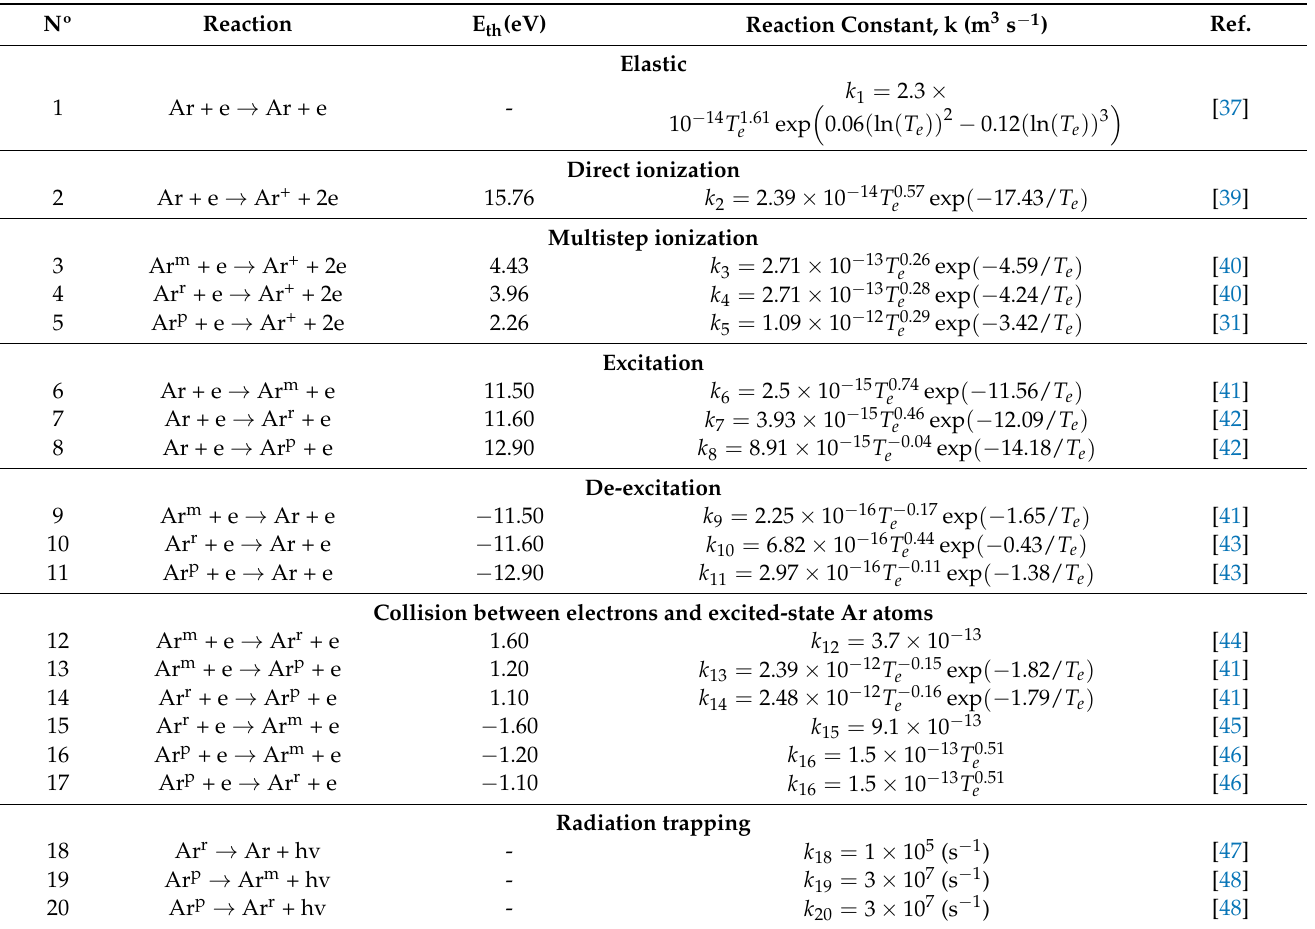
Table 1. Reactions and their corresponding reaction rates for argon used in the calculations. The subscripts r and m denote the resonance and metastable levels of the excited state 4 s and the subscript p denotes the excited state 4 p